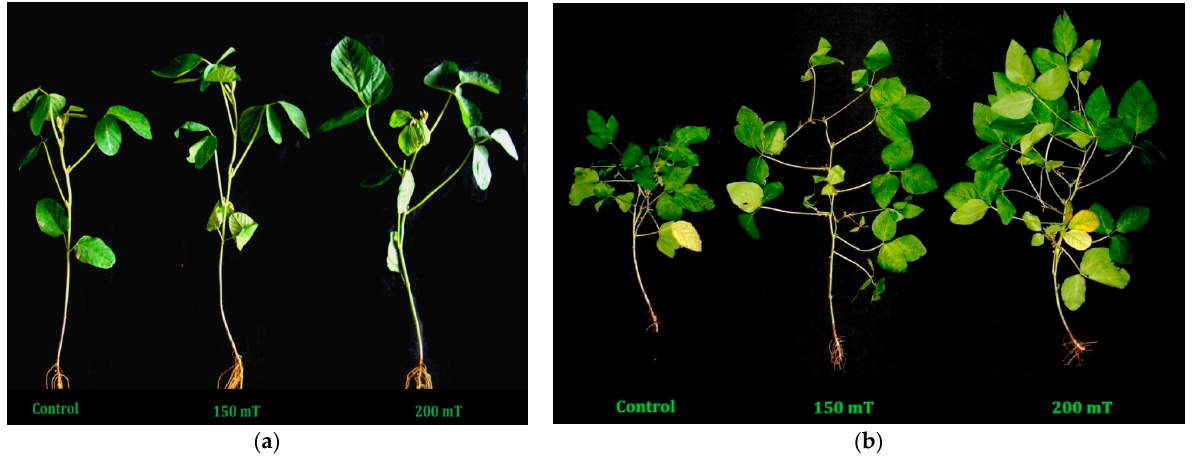
Figure 2. Photograph showing effect of pre-sowing magnetic field treatment of soybean seeds on growth at ( a ) early stage (35 DAE) and ( b ) later stage (55 DAE).